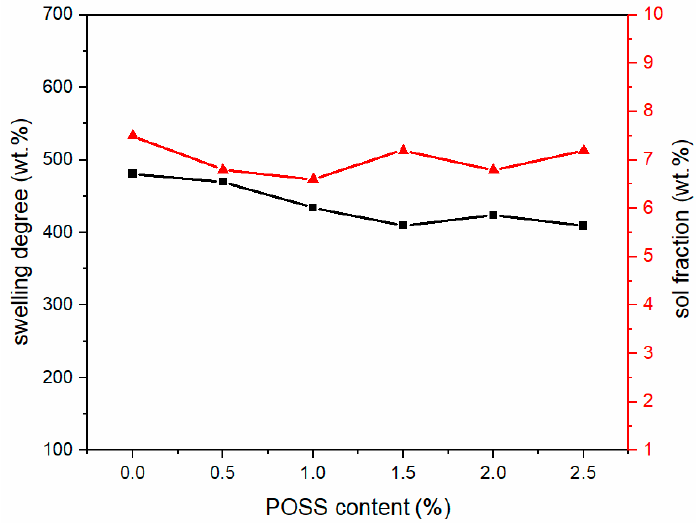
Figure5. Figure 5. The swelling degree and sol fraction curves of polysiloxane foams with different MAPOSS contents.